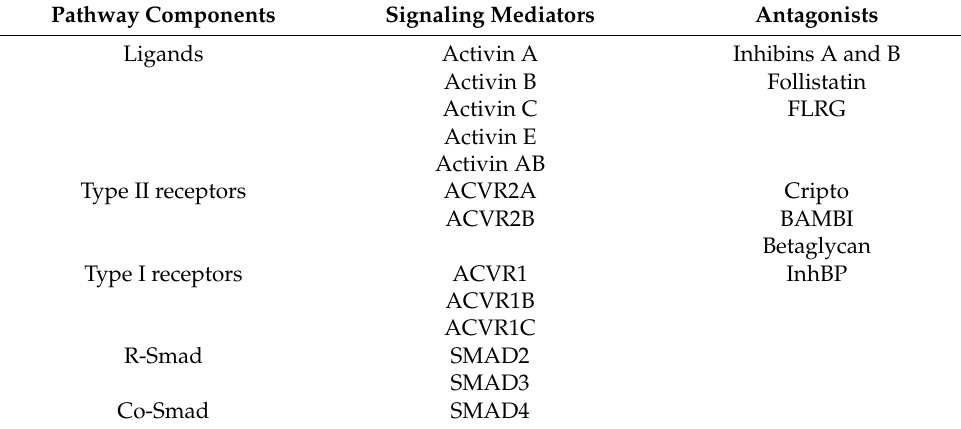
Table 1. Components and modulators of the activin signaling